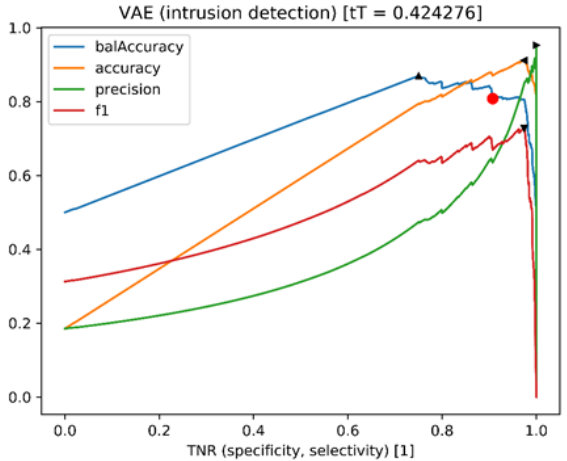
Figure 5. Analysis of the sampling-based variation autoencoder